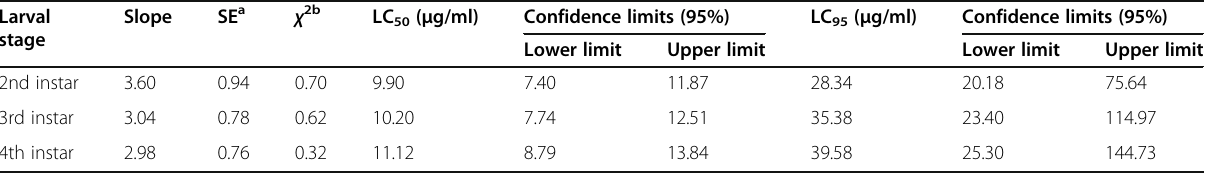
Table 2 Toxicity of 4D4 to 2nd, 3rd and 4th larval instars of tomato pinworm Tuta absoluta Larval stage